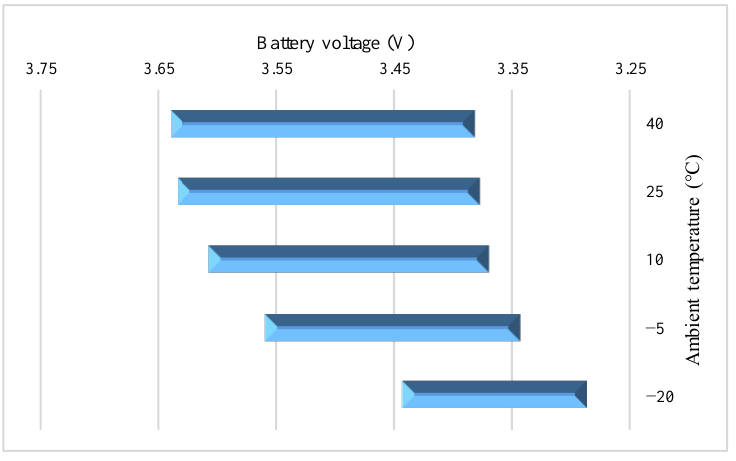
Figure 10. The voltage variation interval diagram of the voltage plateau period during 0.25C dis- charge.